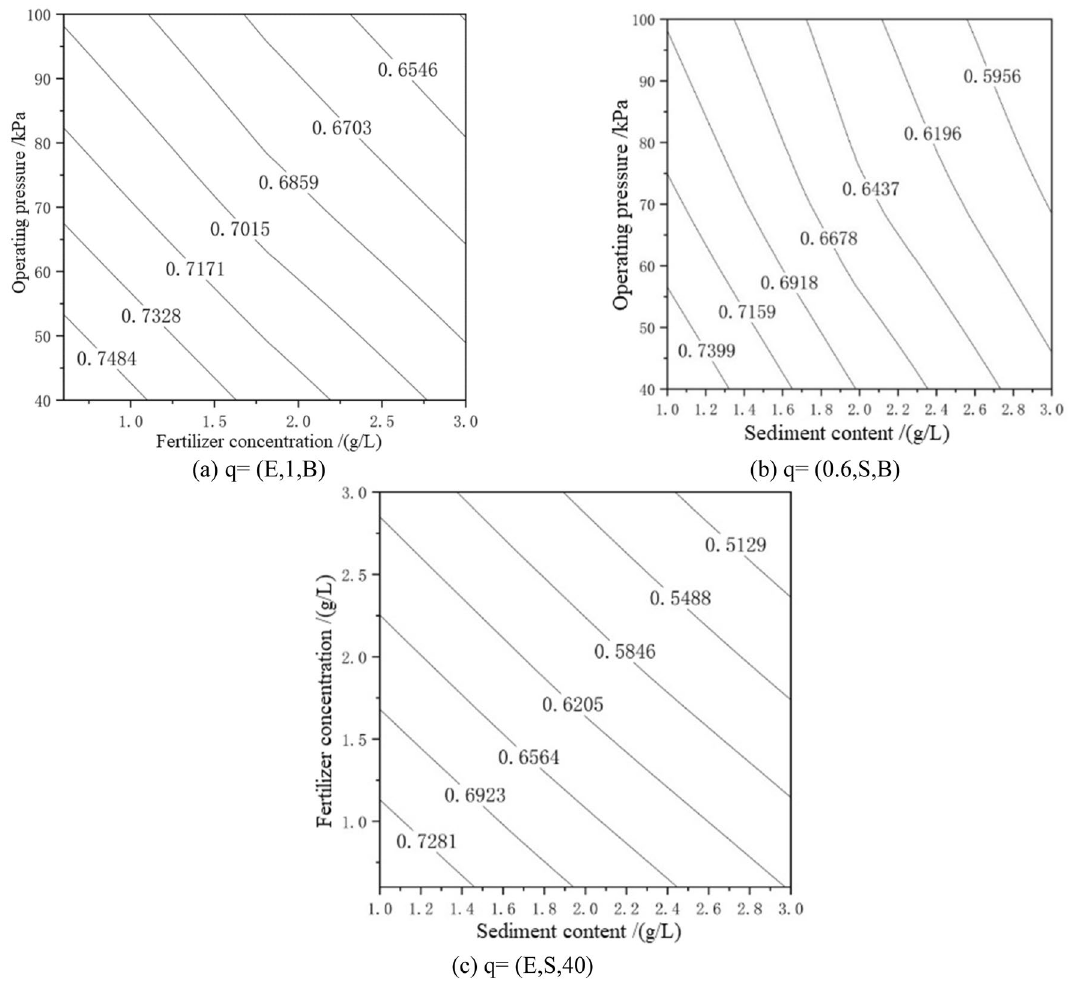
Figure 5. PPR contour map for H2 drip irrigation